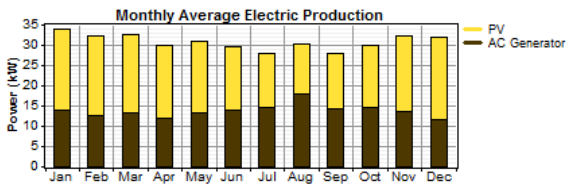
Figure 10: Monthly Average Electric Production for Abeokuta